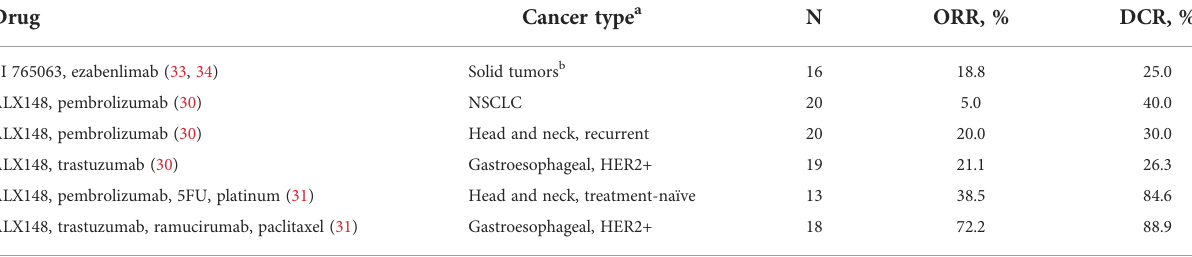
TABLE 3 Study-level data on the ef fi cacy of selective SIRP a blocker combination therapy in solid cancers. Drug